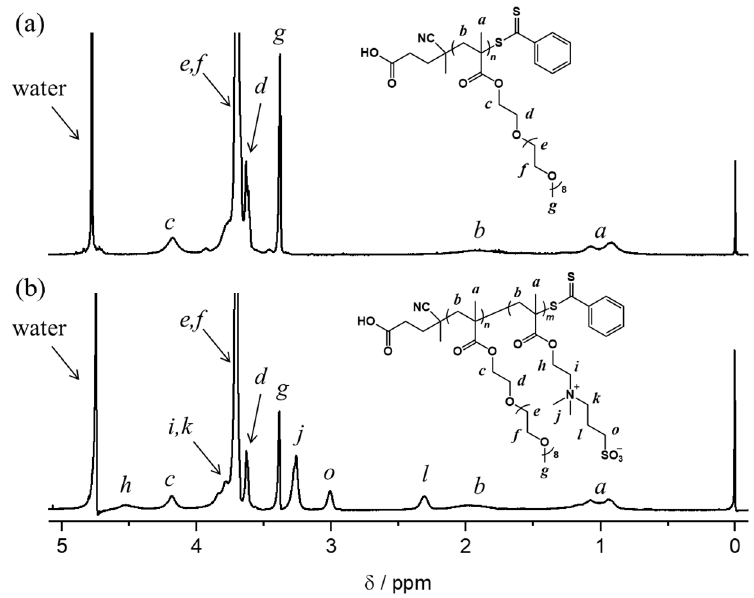
Figure 1. 1 H NMR spectra of ( a ) PPEGMA 68 and ( b ) PPEGMA 68 -b-SPB 121 in D 2 O.